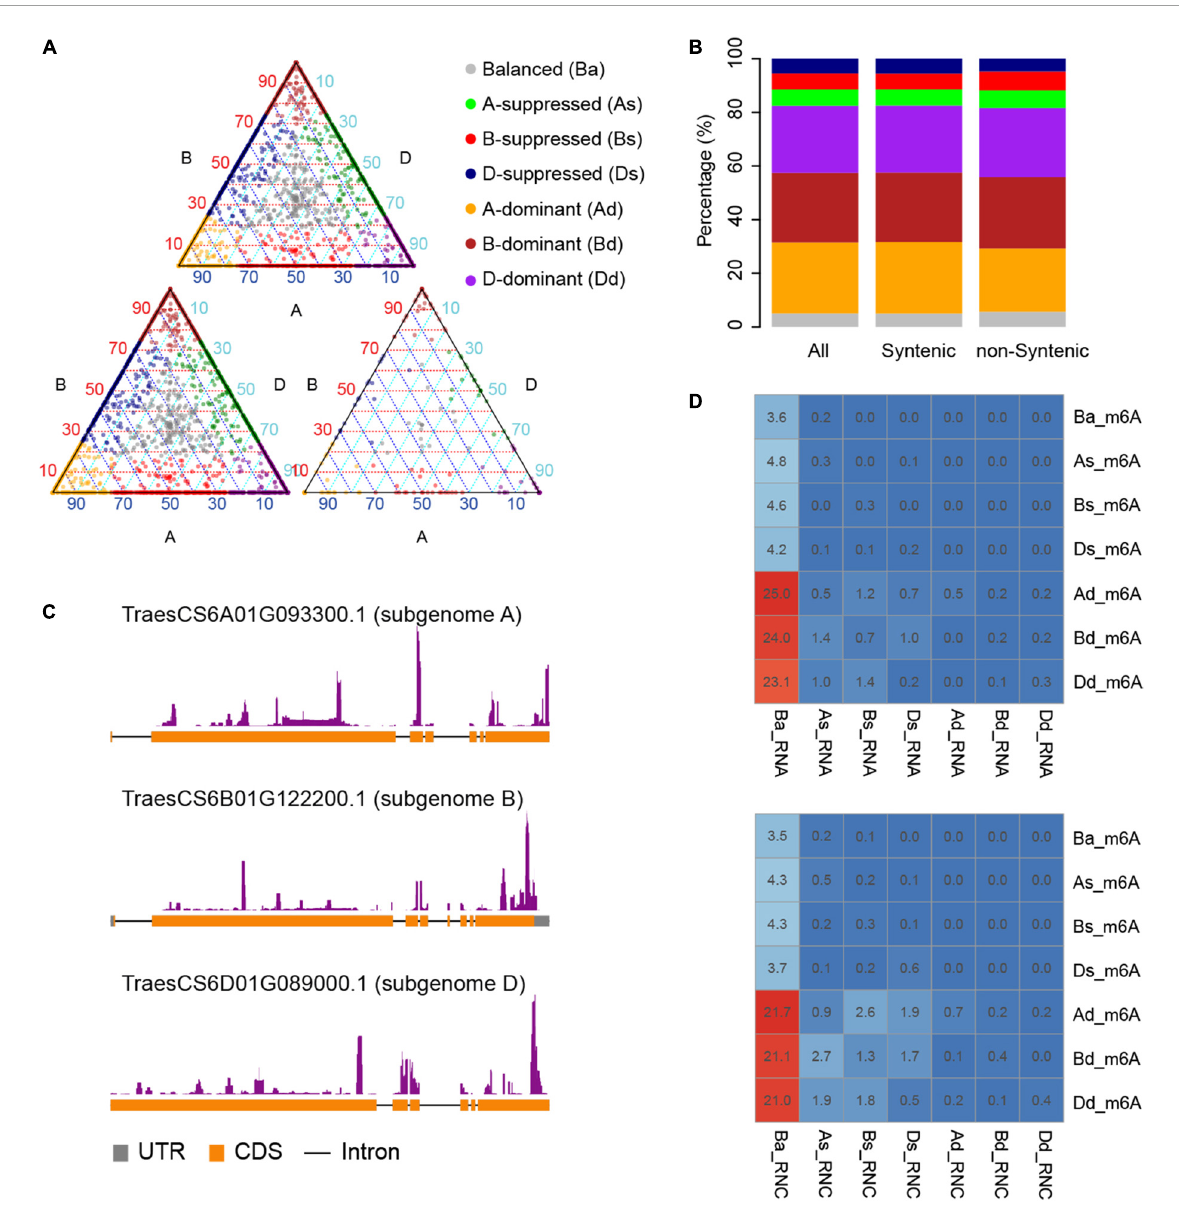
FIGURE2 Divergence of m6A methylation across sub-genomes. (A) The classification of triads including m6A methylated mRNAs. Triads were categorized into seven classes (“A-dominant,” “B-dominant,” “D-dominant,” “A-suppressed,” “B-suppressed,” “D-suppressed,” and “Balanced”) according to the variance of m6A methylation among the homeologous genes. The triangle plot on top shows all the triads, and the bottom left and right triangle plot show the triads located within or outside of syntenic blocks, respectively. The points in the triangle plots indicate the relative degree of methylation across each gene triad (homeologous genes in three sub genomes). (B) The proportion of different classes in synthetic and non-synthetic triads. It uses the same color code as (A) . (C) One example triad showing the variance of m6A methylation positions. Homeologous genes TraesCS6A01G093300.1, TraesCS6B01G122200.1, and TraesCS6D01G089000.1 locate at sub-genome A, B, and D, respectively. (D) The proportion of overlaps between triads classified according to m6A methylation degree, transcription, or translation levels. Triads classified according to m6A degree, transcription (RNA), and translation levels (RNC) were labeled with “_m6A,” “_RNA,” and “_RNC,” respectively, and “Ba,” “As,” “Bs,” “Ds,” “Ad,” “Bd,” and “Dd” are short for “Balance,” “A-suppressed,” “B-suppressed,” “D-suppressed,” “A-dominant,” “B-dominant,” and “D-dominant,” respectively. The numbers in the cells show the percentage of triads for each